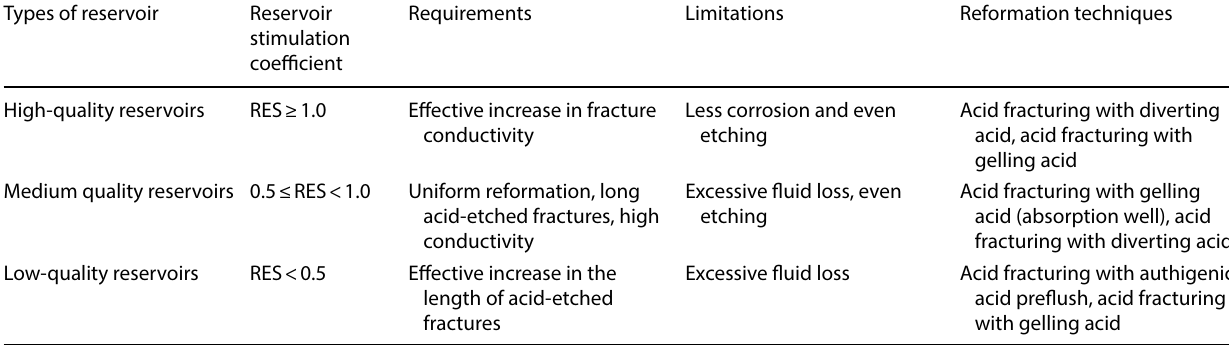
Table 4 Reformation techniques of different quality reservoirs in single well and single interval Reservoir stimulation coefficient